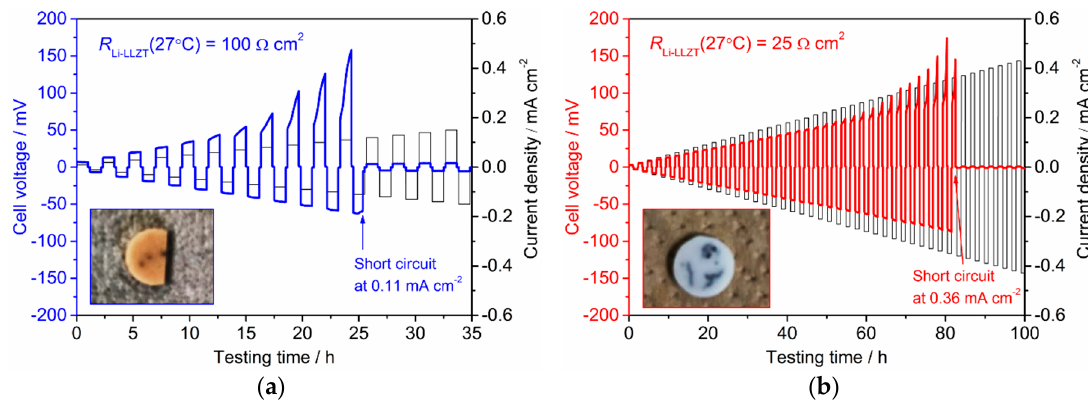
Figure 6. Galvanostatic cycling at 25 °C for Li/LLZT/Li cells with different R Li-LLZT : ( a ) R Li-LLZT (27 °C) = 100 Ω cm 2 and ( b ) R Li-LLZT (27 °C) = 25 Ω cm 2 . The inset in each graph is a photo of an LLZT pellet removed from each cell after a short circuit occurred.